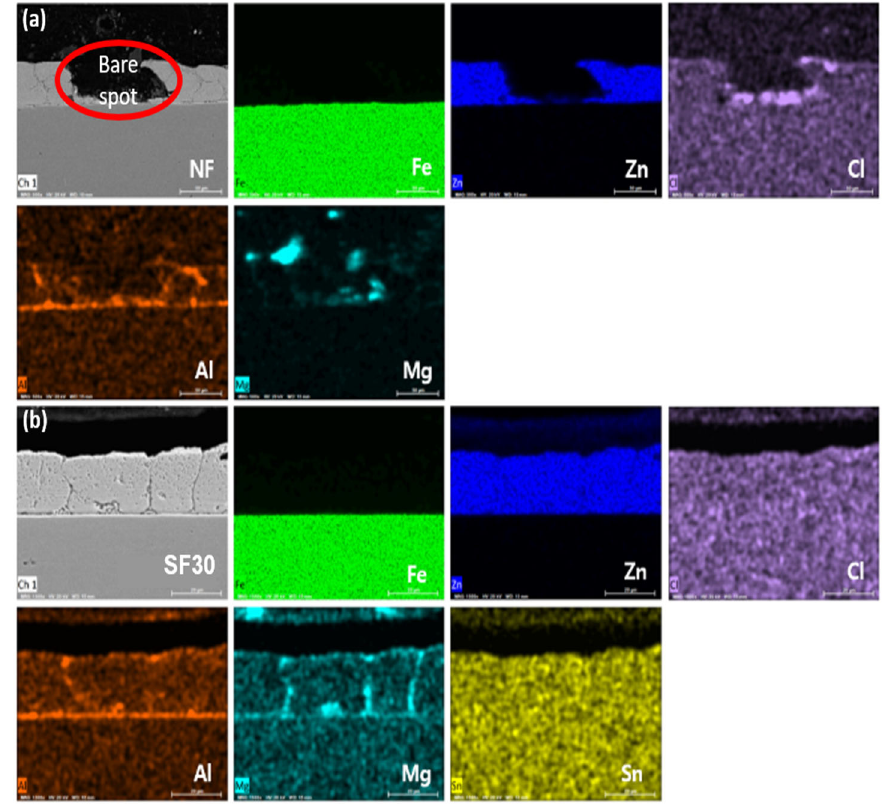
Figure 3. EPMA phase maps of the ( a ) NF and ( b ) SF30 samples of the elements marked at the bottom of the map.